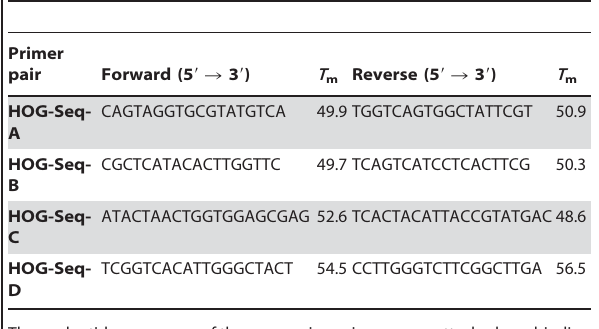
Table 2. Oligonucleotide sequencing primer